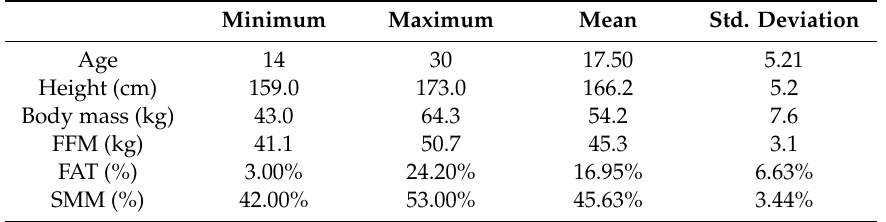
FFM = fat free mass, FAT = body fat percentage, SMM = skeletal muscle mass.